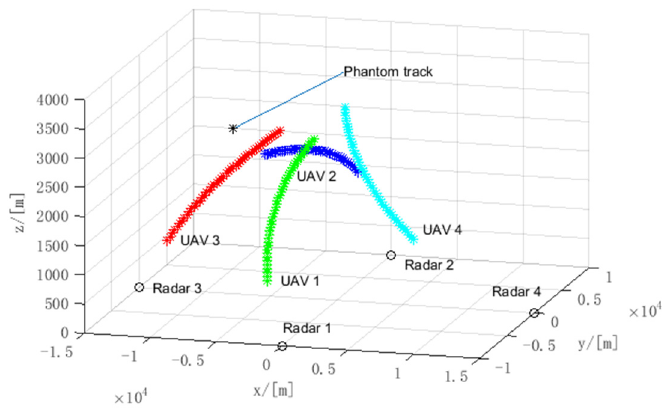
Figure 15. Ideal phantom track deception by four UAVs against four radars.